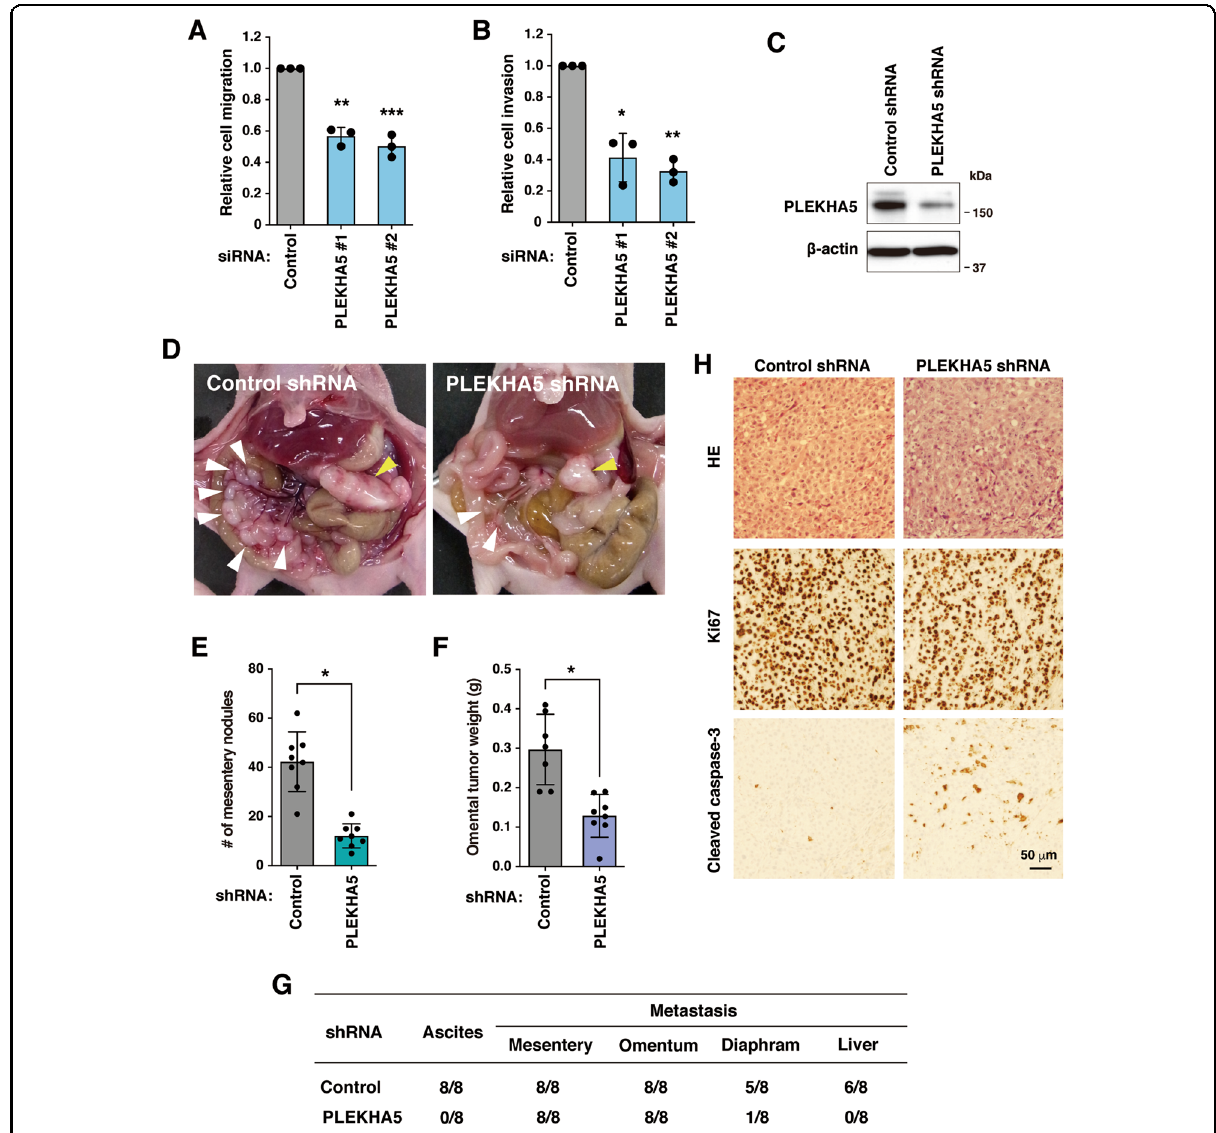
Fig. 5 PLEKHA5 regulates the migration, invasion, and peritoneal dissemination of DGC cells. A , B 58As9 cells transfected with PLEKHA5 siRNA were analyzed for migration through Transwell inserts for 8 h ( A ) or for invasion through Matrigel-coated Transwell inserts for 24h ( B ). Bars, SD ( n = 3). * P < 0.001; ** P < 0.0005; and *** P < 0.0001. C Cells infected with lentiviruses expressing control or PLEKHA5 shRNA were subjected to immunoblotting. D Cells expressing control or PLEKHA5 shRNA were intraperitoneally injected into nude mice. Representative macroscopic views of metastatic tumor nodules formed in the omentum (yellow arrowheads) and mesentery (white arrowheads) are shown. Reddish bloody ascites were seen in the control mice. E The number of mesenteric tumor nodules equal to or larger than 1 mm in diameter. Bars, SD ( n = 8). * P < 0.001 by the Mann – Whitney test. F Omental tumor weight. Bars, SD ( n = 7 for control and 8 for PLEKHA5 shRNA). * P < 0.001 by the Mann – Whitney test. G Number of mice bearing ascites or tumors at the indicated site per total number of mice bearing tumors. H Omental tumor sections were stained with hematoxylin and eosin and with anti-Ki67 and cleaved caspase-3